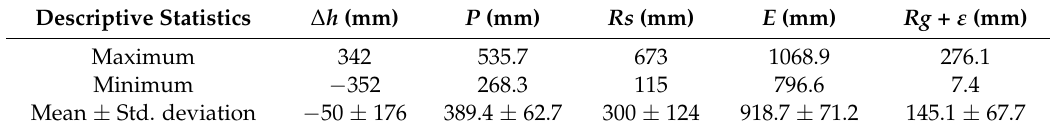
Table 6. Characteristic of the factors of the water balance of Qinghai Lake from 1961 to 2010. Descriptive